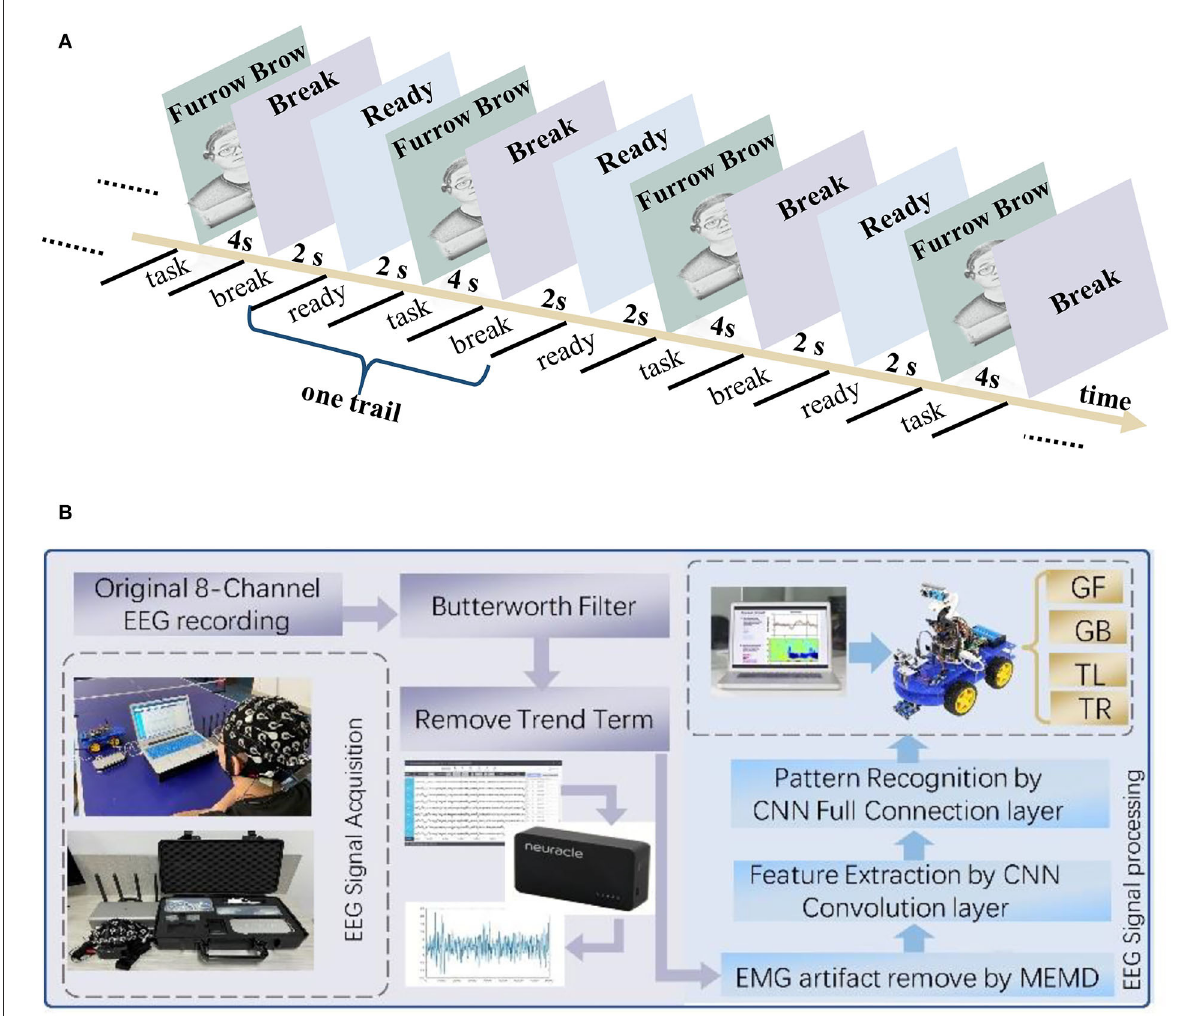
FIGURE2 FE-BCI system and its experimental protocol. (A) Experimental protocol for the offline experiment. (B) Scheme of FE-BCI system for an intelligent